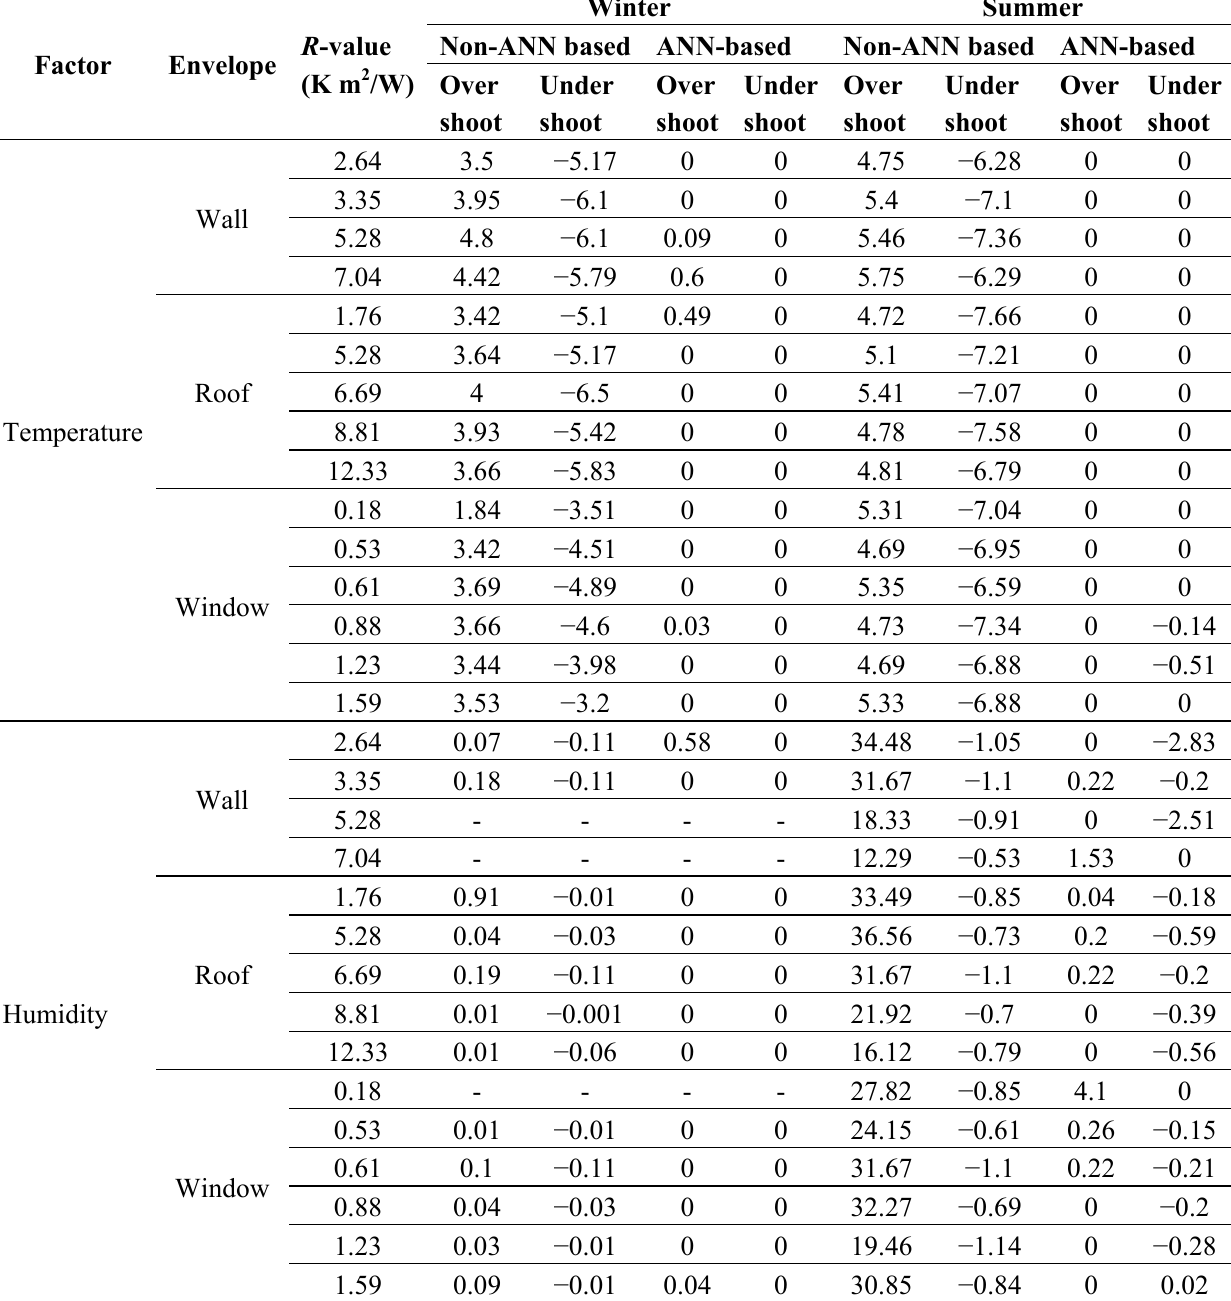
Table 9. Magnitude of overshoots and undershoots of air temperature and humidity based on envelope insulation.